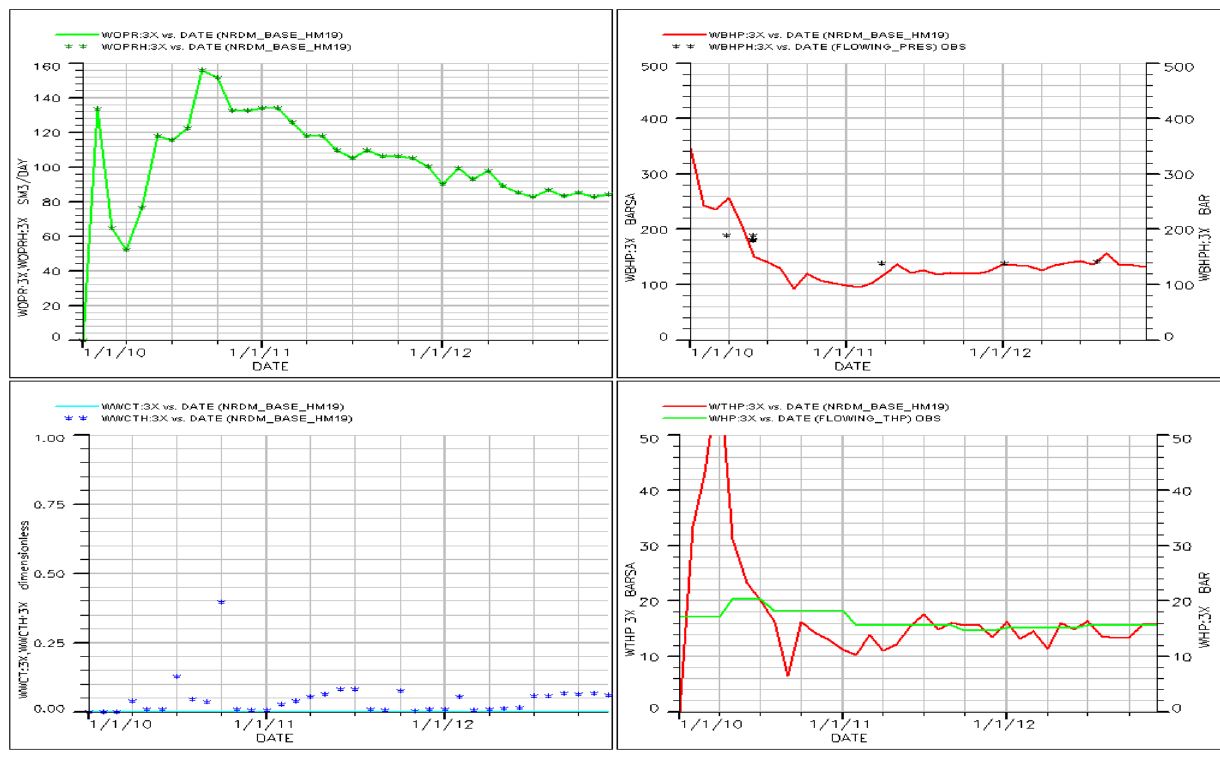
Fig. 8 Matching results of well 3X